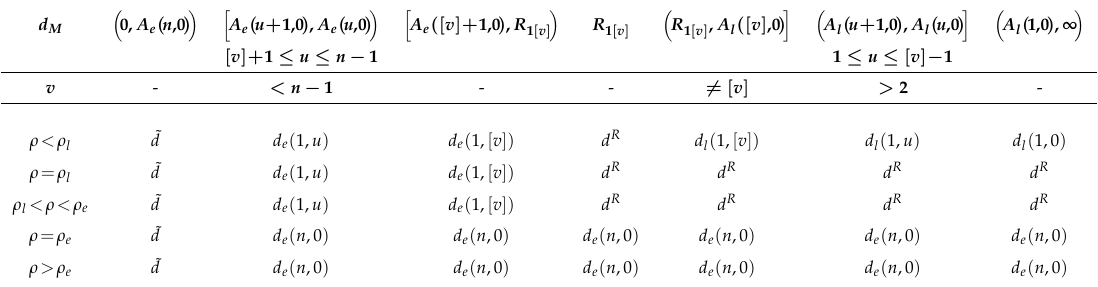
Table 8. Optimal solutions d (cid:63) n with respect to ρ and d M for 1 < v < n . The column headings reporting